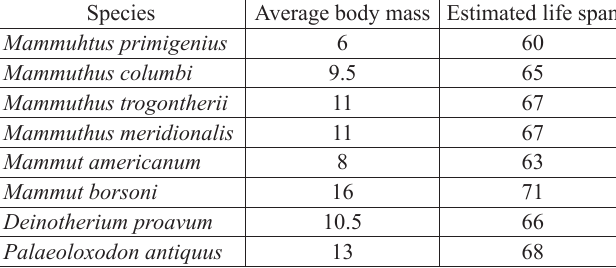
Table 5. Estimation of lifespan (in years) of different proboscidean species based on the calculated average body mass (in tonnes), after Blueweiss et al.’s (1978)